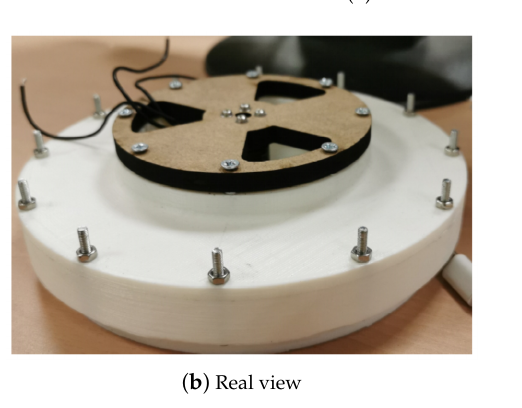
Figure 2. Suction system: housing, impeller (in red) and motor